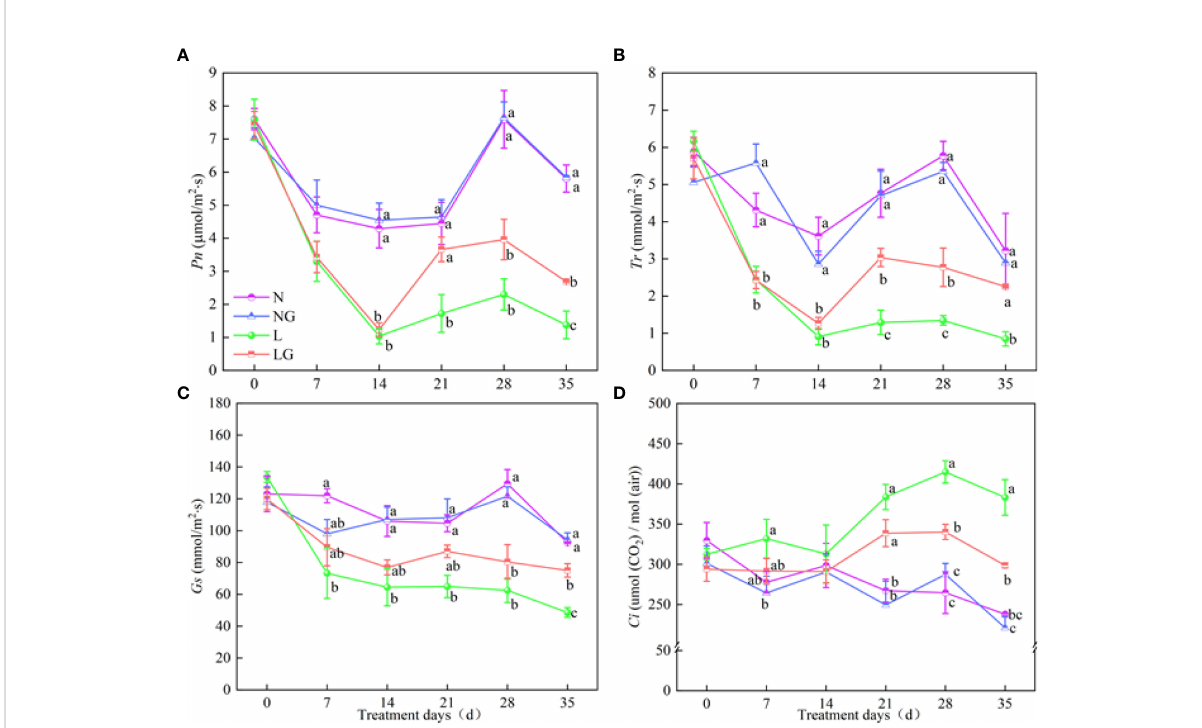
FIGURE 5 Effects of GABA spraying on photosynthetic parameters in M. ruthenica seedlings on different treatment days. (A) The net photosynthetic rate (Pn) in leaves; (B) transpiration rate (Tr) in leaves; (C) stomatal conductance (Gs) in leaves; (D) intercellular carbon dioxide concentration (Ci) in leaves. N, the plant pretreated with distilled water and grown at normal temperature. NG, the plant pretreated with GABA and grown at normal temperature. L, the plant pretreated with distilled water and grown at low temperature. LG, the plant pretreated with GABA and grown at low temperature. Different lowercase letters indicate signi fi cant differences between N, NG, L, and LG on the same treatment day ( P < 0.05). Those not marked with letters under the same treatment day indicate that there is no signi fi cant difference between treatments.